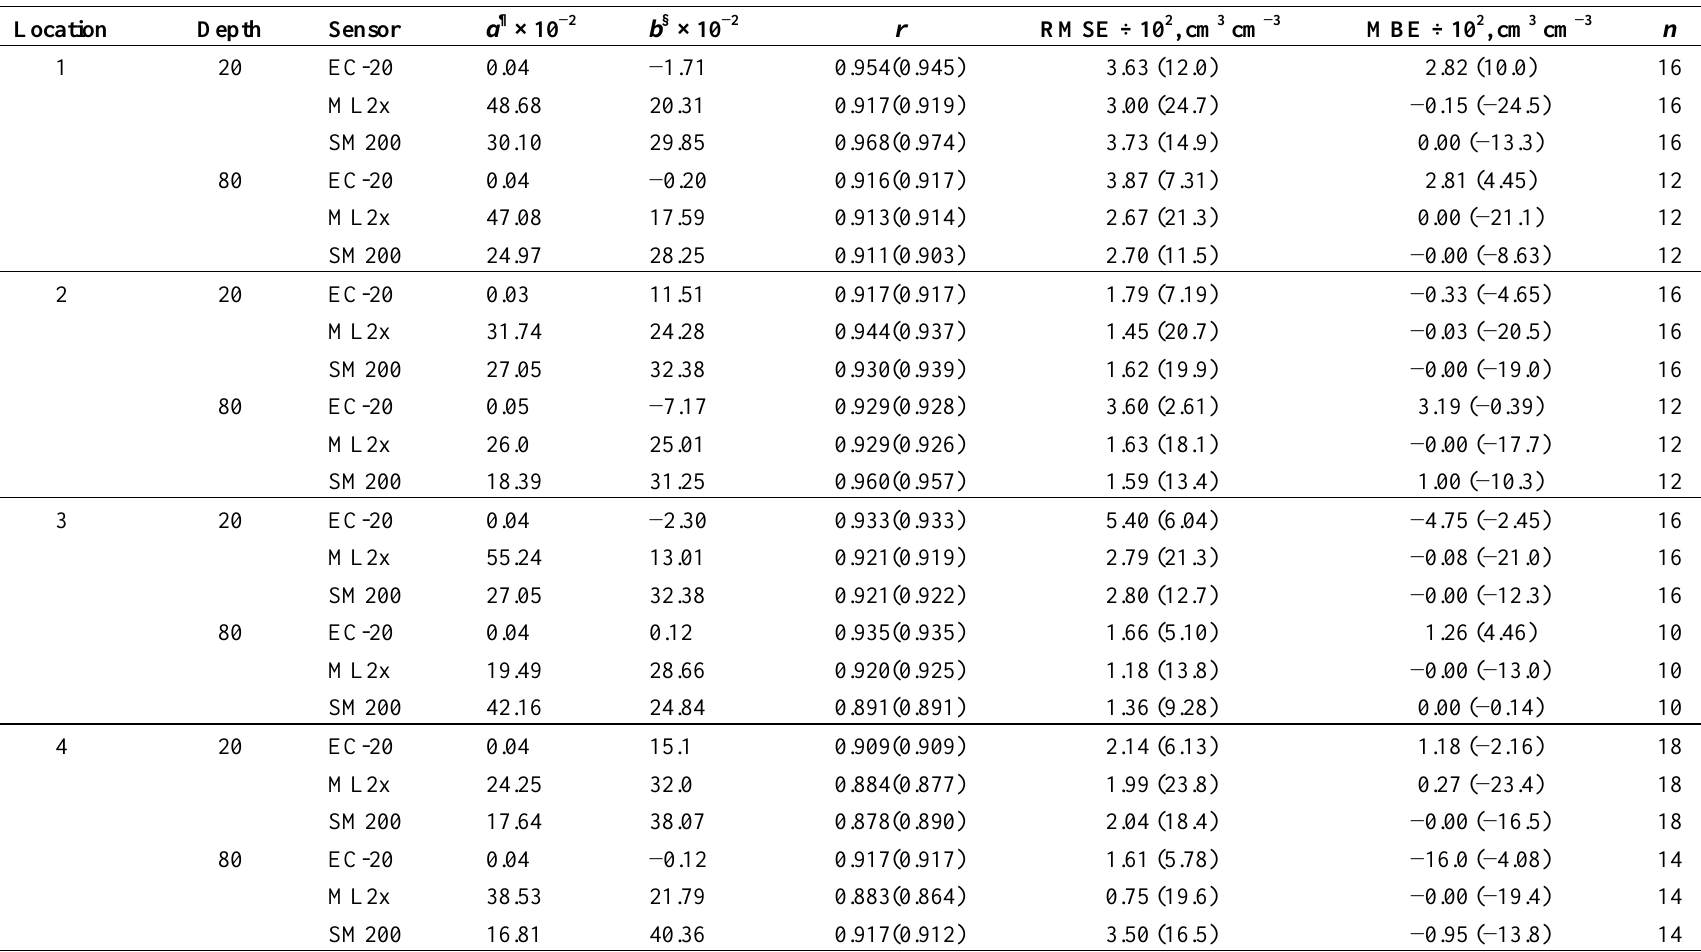
Table 5. Equation parameters and statistical indices for the laboratory calibration equations for EC-20, ML2x, and SM200. The values of root mean square error (RMSE) and mean bias error (MBE) from the comparison of actual water content with that calculated from the default sensor equations in